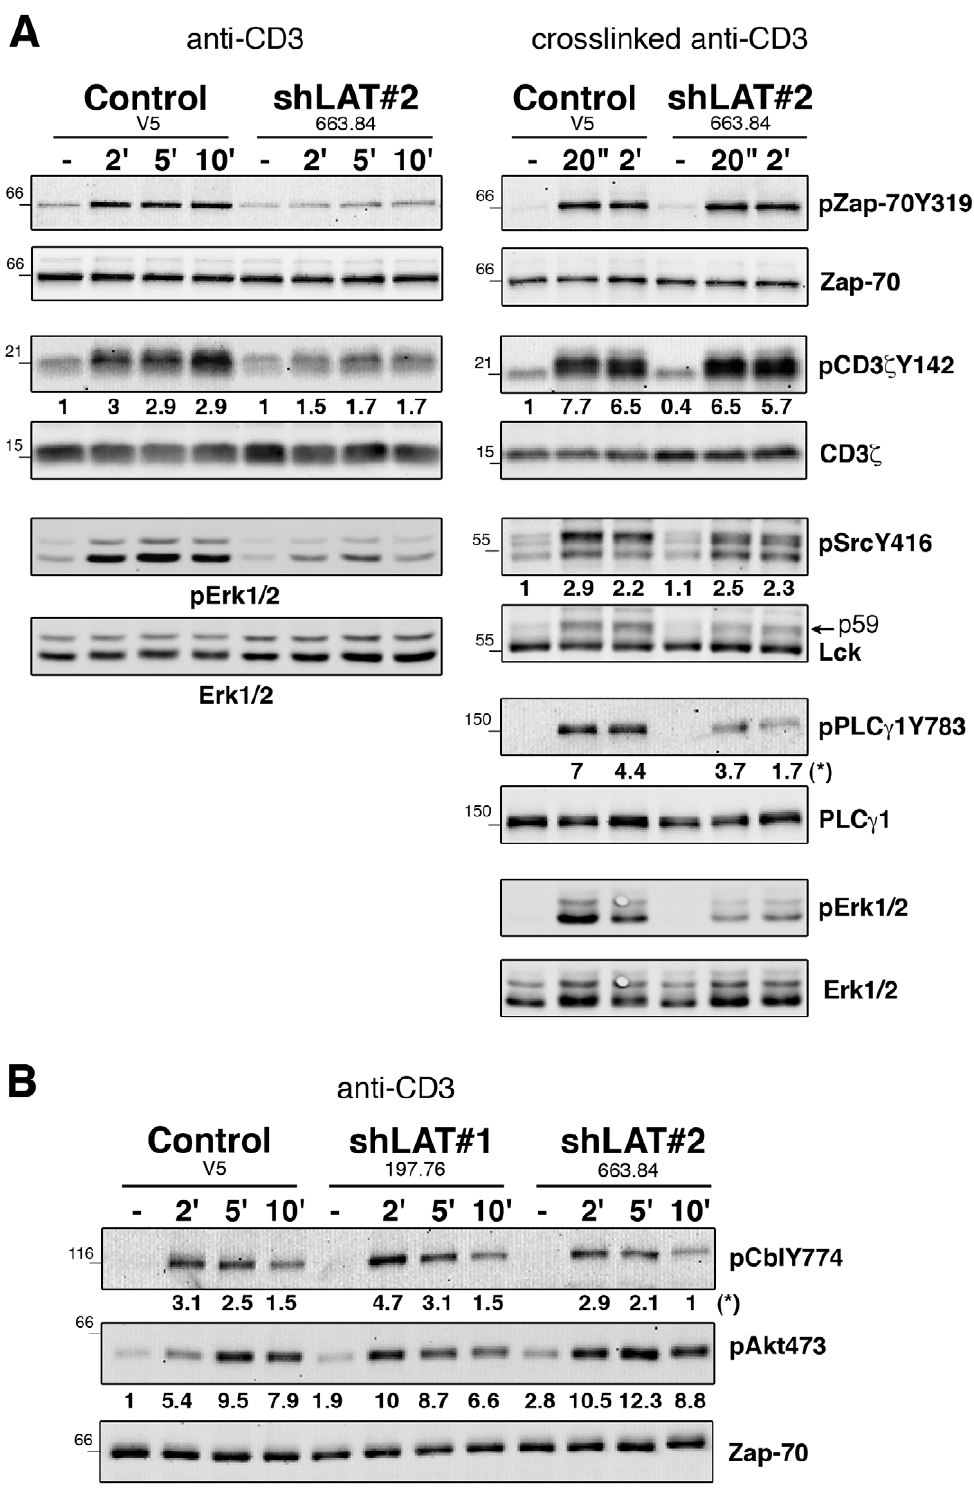
Figure 6. Decreased phosphorylation of Lck substrates in Hut-shLAT cells depends on TCR stimulation strength. (A) Control and Hut- shLAT # 2 cells were stimulated with anti-CD3 or by crosslinking anti-CD3 (left and right panels, UCHT1, 5 m g/ml). Cell lysates were analyzed by immunoblotting for phosphorylation of Zap-70, TCR f chain, SrcY416, PLC c 1 and Erk1/2. Numbers indicate fold inductions of phosphorylation after normalization to protein loading and unstimulated control cells. (*) raw values of phosphorylation after normalization to PLC c 1. Data are representative of at least three independent experiments. (B) Cell lysates from cells stimulated as in A were analyzed for the phosphorylation of c-Cbl and Akt. Data were normalized relatively to Zap-70.